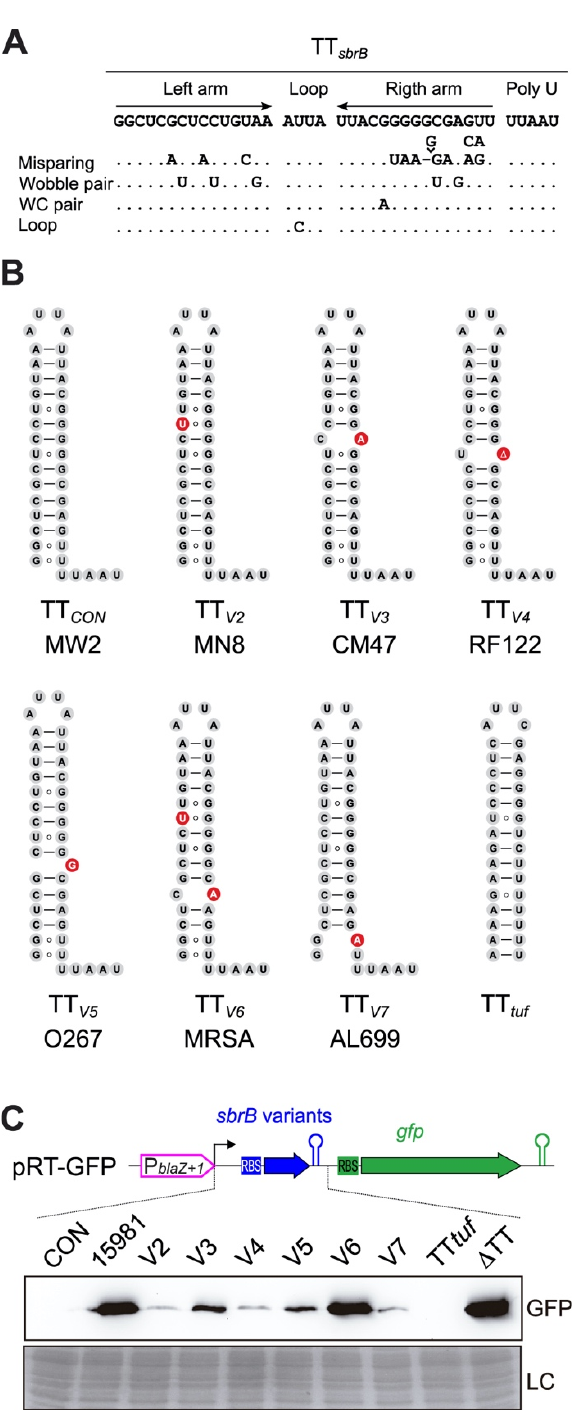
Figure 5. Natural mutations found in the TT sbrB sequence influence the read-through levels. ( A ) Localization of nucleotide variations found in the TT sbrB . The changes in the TT structure produced by the mutations are indicated. ( B ) Putative RNA structures of selected TT sbrB variants. Mispairing nucleotides are highlighted in red. Frequencies of the mutations among staphylococcal strains are indicated in Table S4. ( C ) Western blot analysis showing the levels of transcriptional read-through (RT) produced by the different nucleotide variations were monitored by measuring the GFP expression. The different sbrB mRNA variants were cloned upstream of the gfp gene reporter and expressed under the control of the P blaZ +1 promoter. Total proteins transferred to nitrocellulose membranes were incubated with monoclonal anti-GFP and developed with peroxidase-conjugated goat anti-mouse antibodies and a bioluminescence kit. Coomassie gel portions are included as loading controls